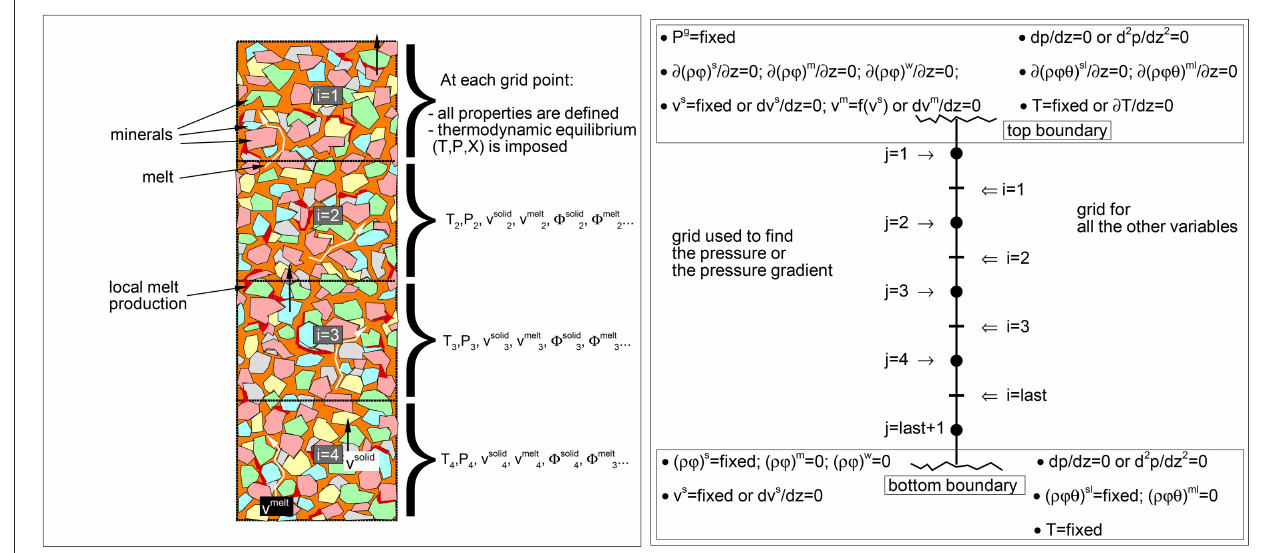
FIGURE 1 | (Left) Schematic view of the mantle column. In the dynamic equilibrium melting (DEM) model at each grid point local equilibrium is assumed between melt and solid. Dynamic and thermodynamic properties represent the average spatial values within each grid point. The drawing describes only the concept of the model, distribution of melt and minerals in the figure not in scale. (Right) Illustration of the two spatial grids, the j-grid used for the pressure or the pressure gradient, and the i-grid for all the other variables. Boundary conditions at the top and bottom of the model are also reported. The zero gradient condition, for example ∂ ( ρφ ) /∂ z = 0, means that ( ρφ ) topboundary = ( ρφ ) i = 1 or ( ρφ ) bottomboundary = ( ρφ ) i = last